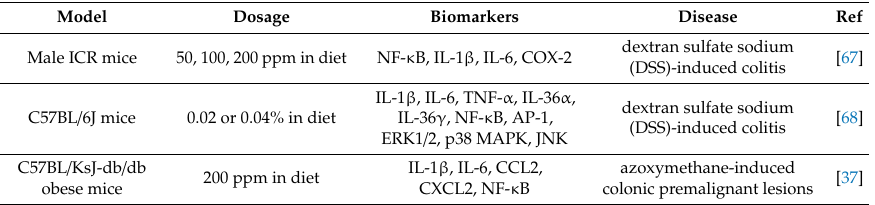
Table 2. The anti-inflammatory e ff ects of astaxanthin in gastrointestinal